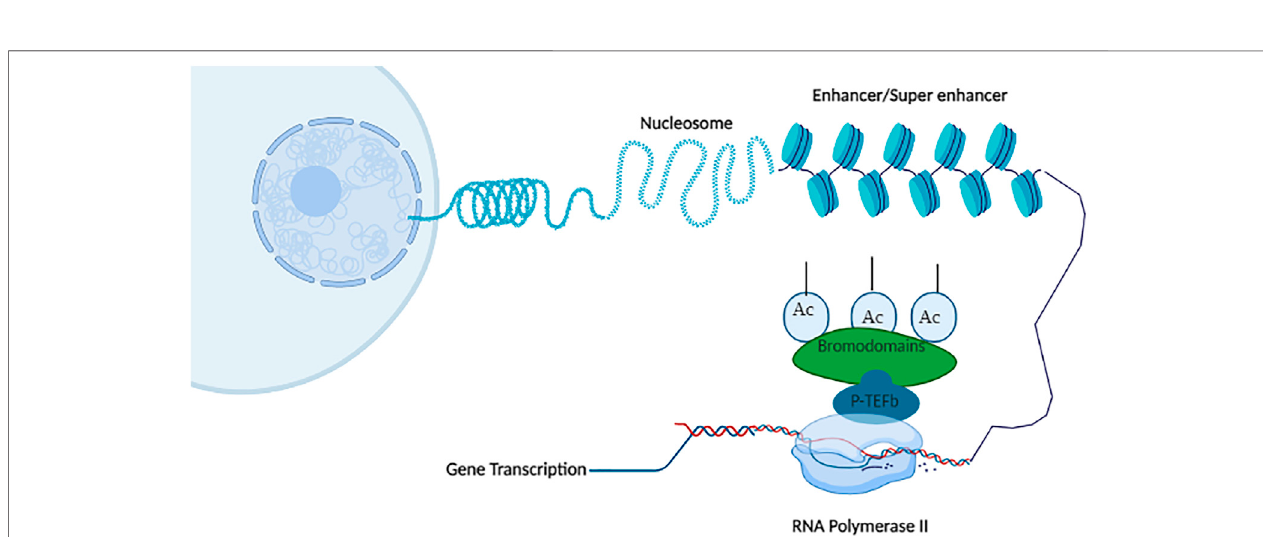
FIGURE 3 | Summery of functional classi fi cation of human bromodomain protein.